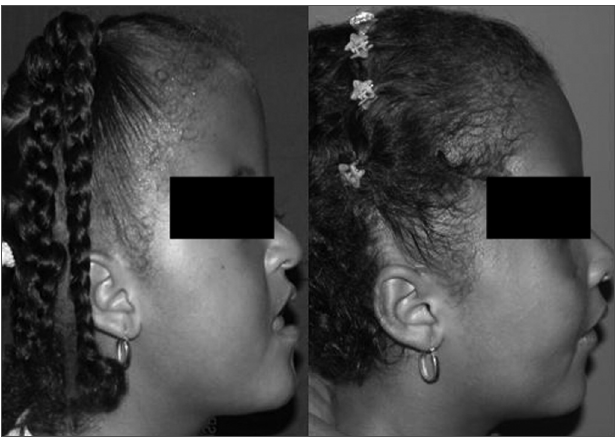
Figure 2. Patient undergoing monobloc frontofacial osteotomy and facial bone lengthening with a rigid external distractor. Left: preopera- tive. Right: one-year